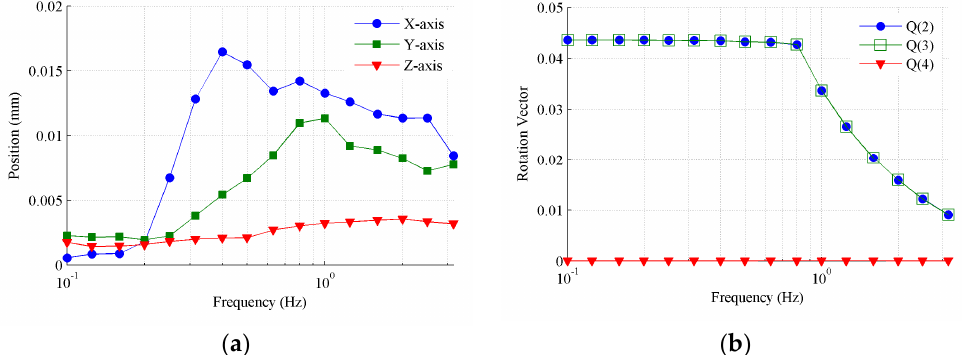
Figure 7. Conical motion around the Z-axis generated by the Stewart platform. ( a ) Amplitudes of position; ( b ) amplitudes of orientation where the legend Q(i) (i = 2, 3, 4) stands for the ith element of the quaternion for the orientation expression.